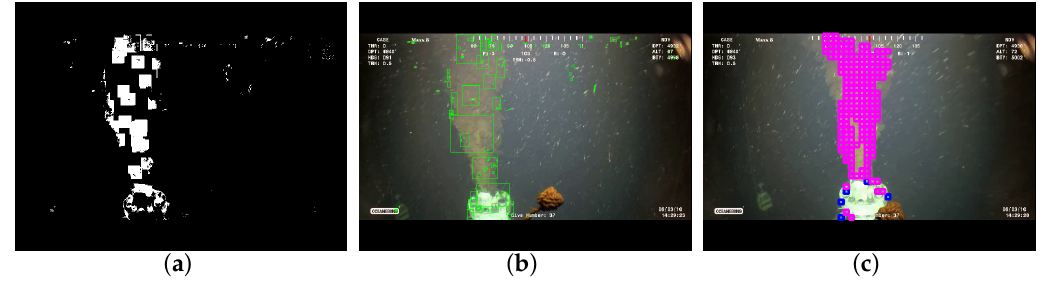
Figure 6. detection results: ( a ) fusion-mask; ( b ) pre-detection; and ( c ) cell stacks.